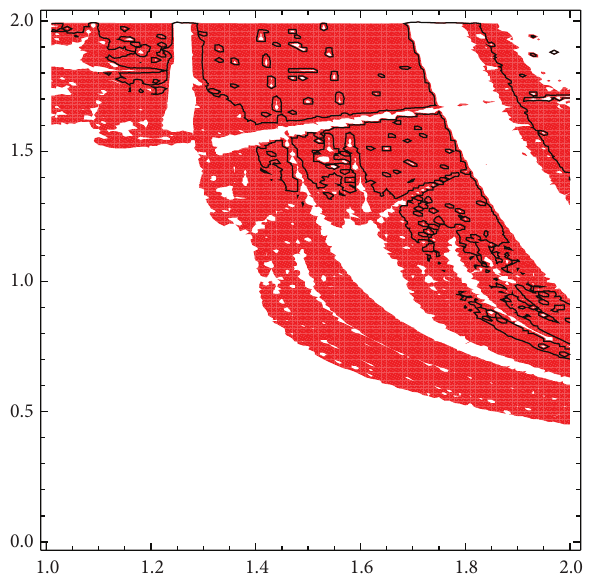
Figure 14: We take orbits of length 𝑛 = 10000 of 𝑔 𝛽 ∘ 𝑓 𝛼 with initial conditions on the image of the turning points and estimate the Lyapunov exponent for (𝛼,𝛽) ∈ [1,2]×[0, 2] with step size of 0.01. In red we draw those values of the parameter for which the maximum of Lyapunov exponents for the turning points is smaller than or equal to 0.